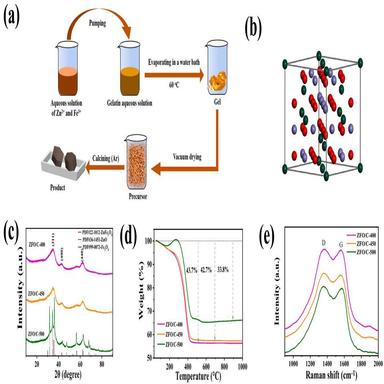
(a) Synthesis route of ZnFe2O4/C composites; (b) Spinel structure of ZnFe2O4; (c) XRD patterns, (d) Raman spectra, and (e) TGA profiles of all the materials.